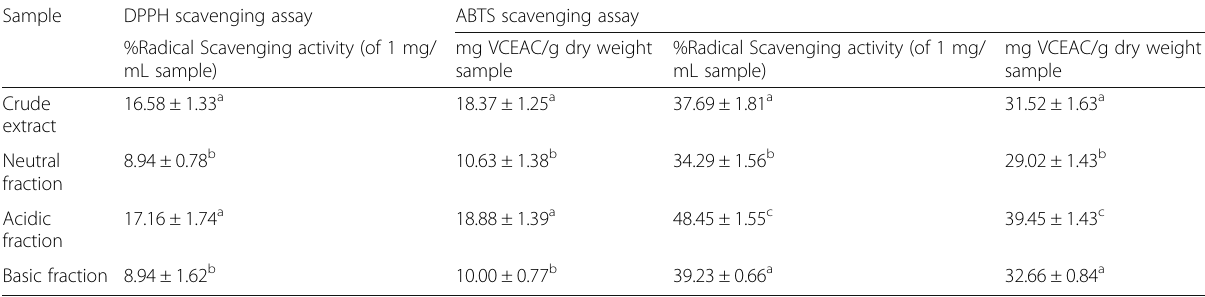
Table 3 Antioxidant capacities of the crude ethanolic extract of S. asper leaves and its fractions determined by the DPPH and ABTS scavenging assays